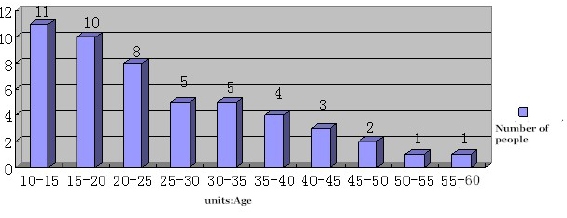
Figure 3-2 The age of the Yi wrestling participants in Shilin